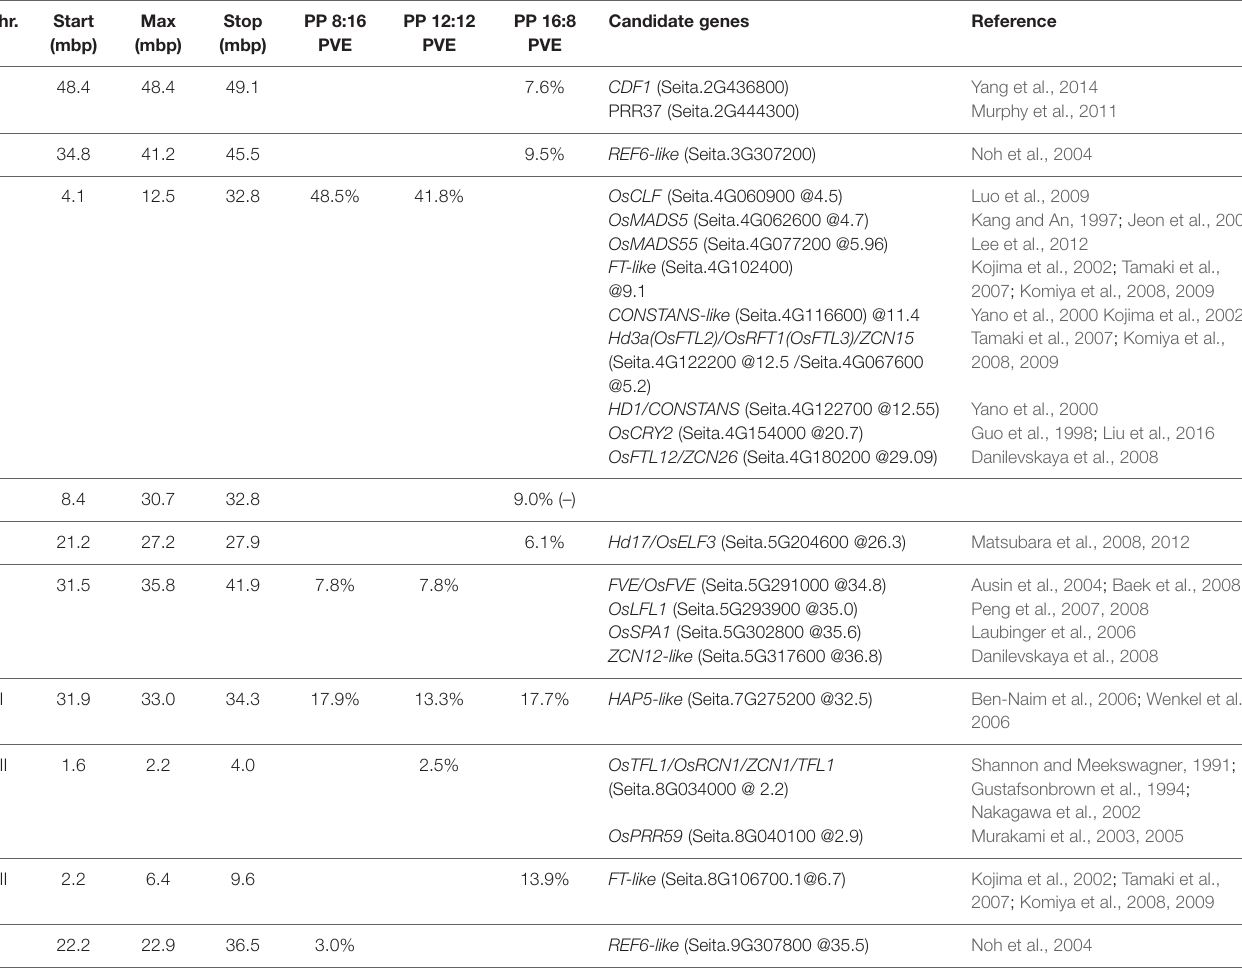
TABLE 3 | Position of QTL intervals and percent variation explained (PVE).